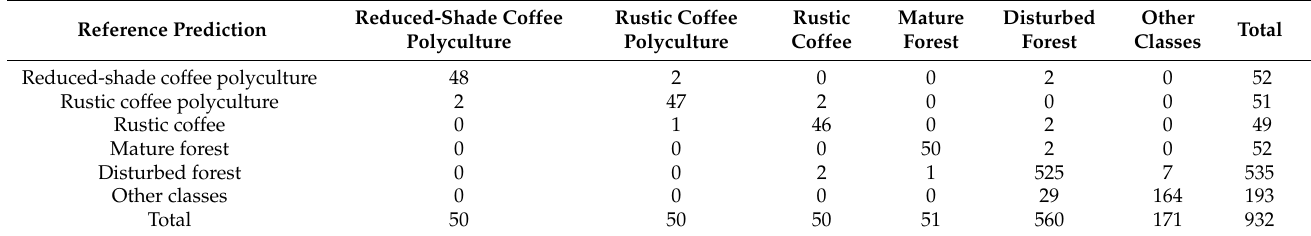
Table 5. Confusion matrix generated using 932 validation sites.